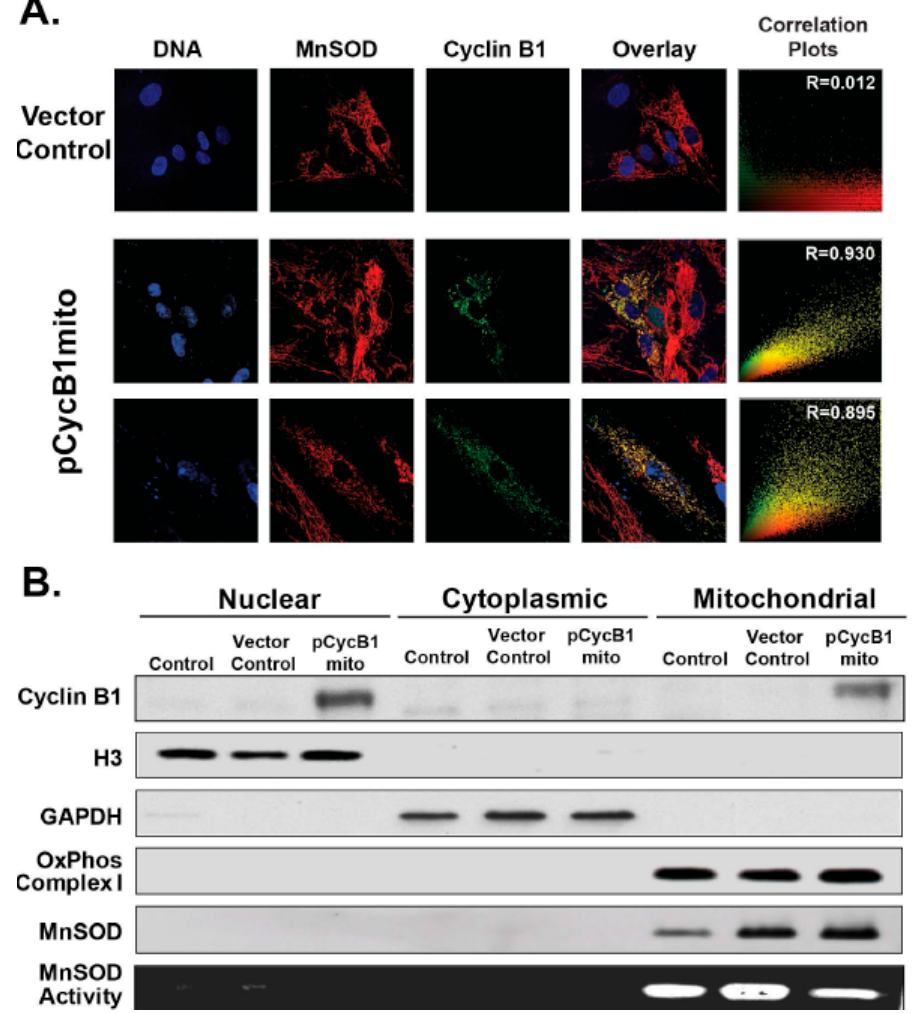
Figure 7. Mitochondrial overexpression of cyclin B1. Quiescent NHFs (1 × 10 6 ) were transfected with 0.5 microgram of plasmid DNA and Arrest-In Transfection Reagent (Open Biosystem) following the